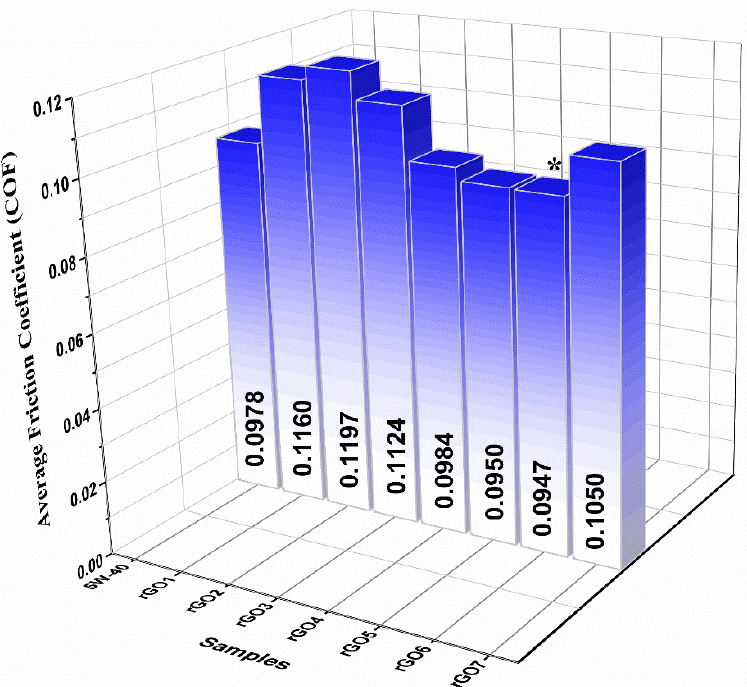
Figure 8. Average COF values histogram of the reference 5W-40 engine oil and the samples incorporating reduced graphene oxide (rGO) 0.2–0.01 wt %. The sample exhibited the lowest average COF value is denoted by an asterisk. The standard deviation in these data are 1%.